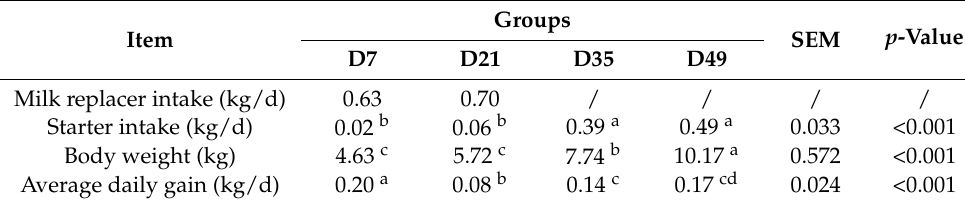
Table 4. Intake, body weight and average daily gain of lambs at different sample times.